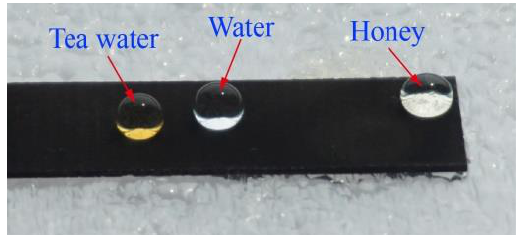
Figure 7. Photograph of different liquid droplets on the as-prepared superhydrophobic surface.